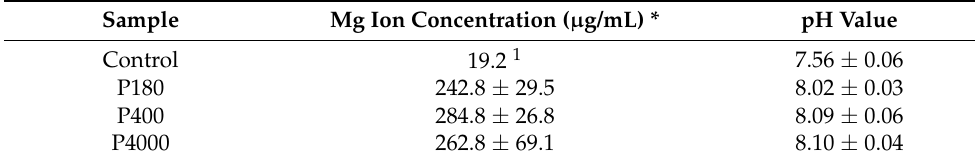
Table 2. Analysis result of sample